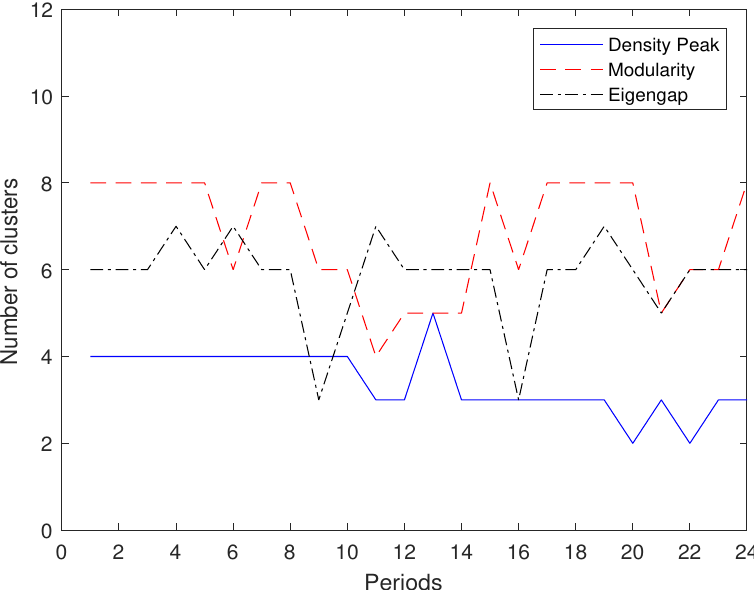
Figure 15. The number of clusters obtained by applying the density peak, the modularity and the eigengap methods for each time period.